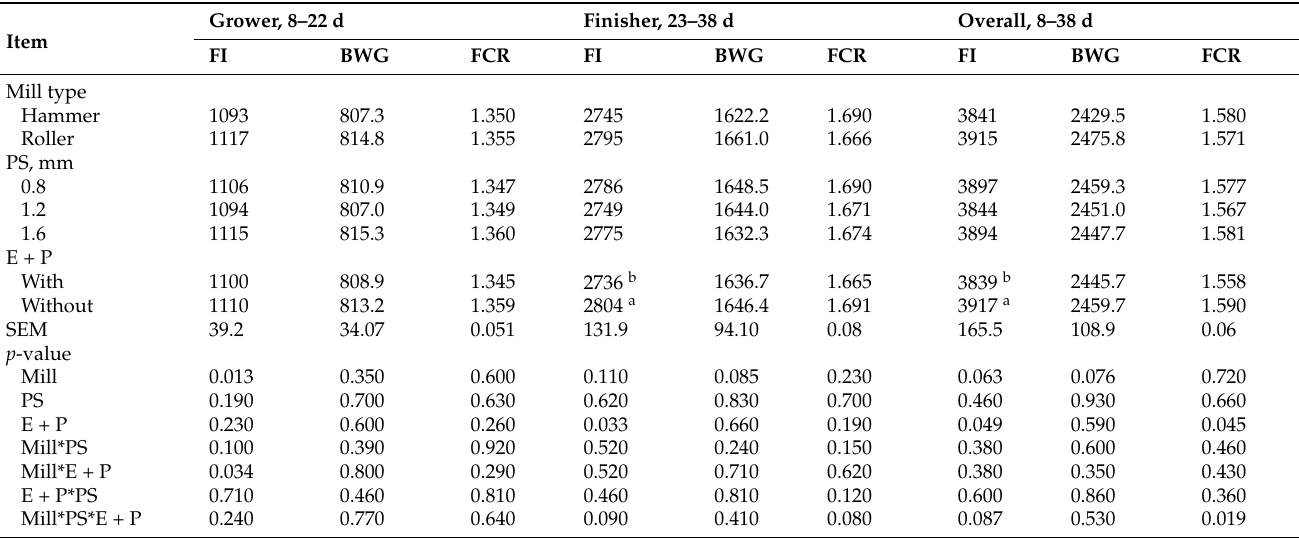
Table 5. Performance of broilers fed diets ground with two types of mill at three particle sizes (PSs), submitted to conditioning with or without expander (E + P) prior to pelleting, measured from 8 to 38 days